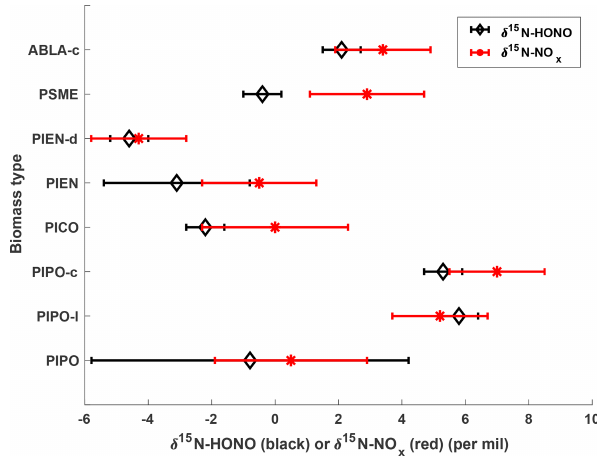
Figure 3. Comparison of ADS-measured HONO concentration with the mean values of various high-resolution methods including MC–IC, FTIR, ACES, and PTR-ToF for available fires. Solid lines are linear regressions of each dataset with the same symbol color.